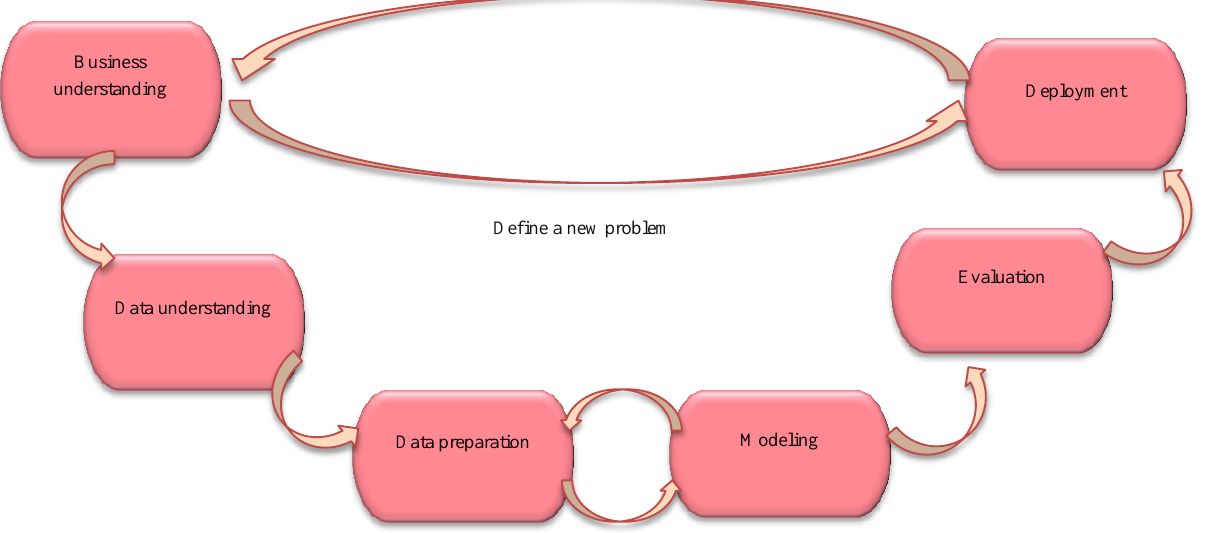
Figure 1. Steps of a DM